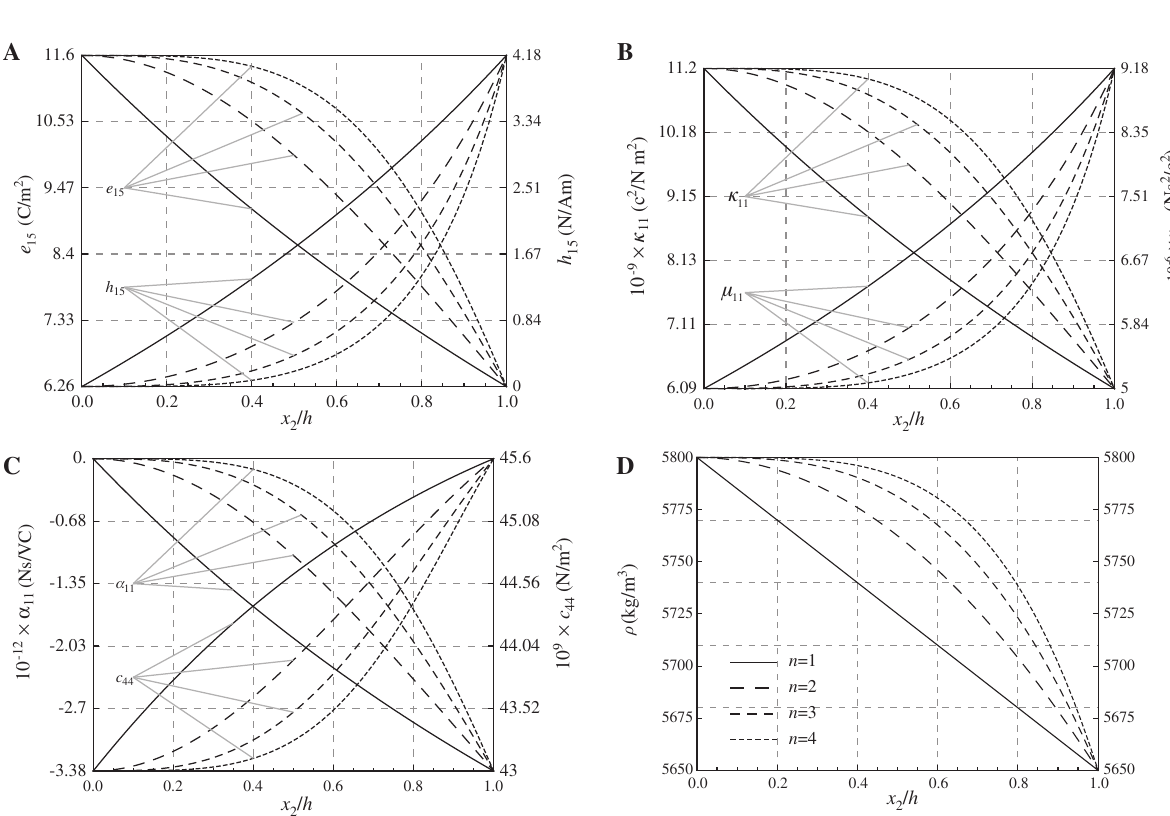
and h , (B) κ and μ , 15 15 11 11